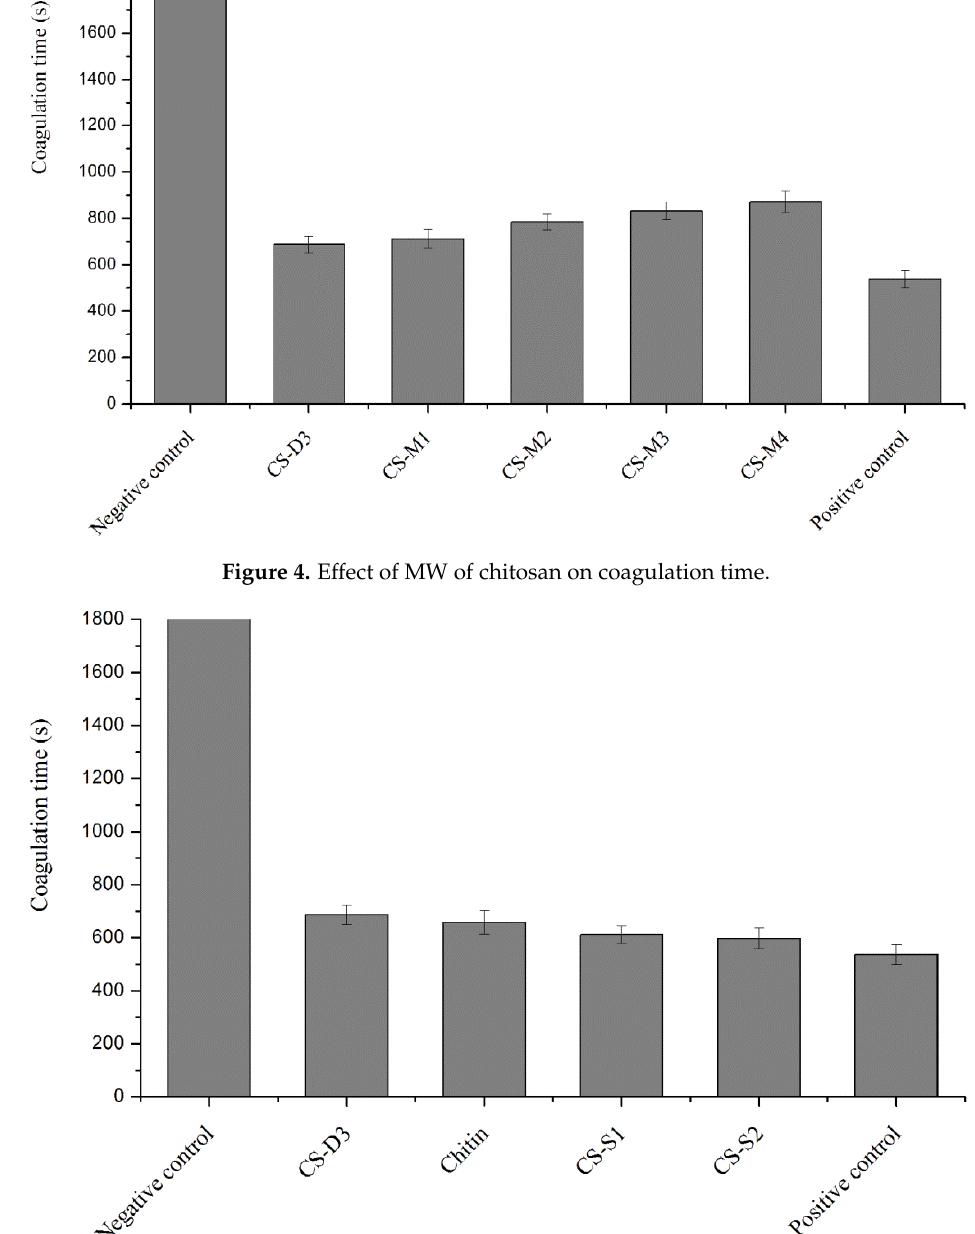
Figure 5. Effect of substitution group of chitosan on coagulation time.